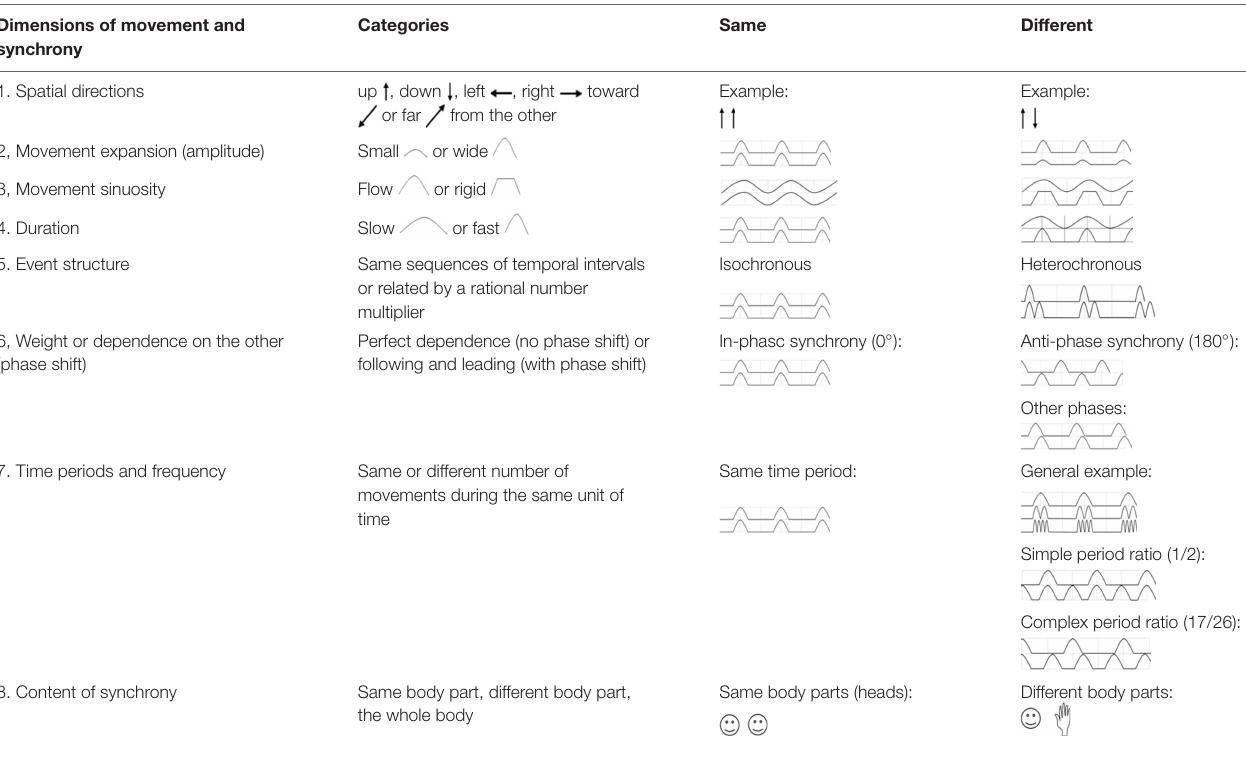
TABLE 1 | Dimensions of movement